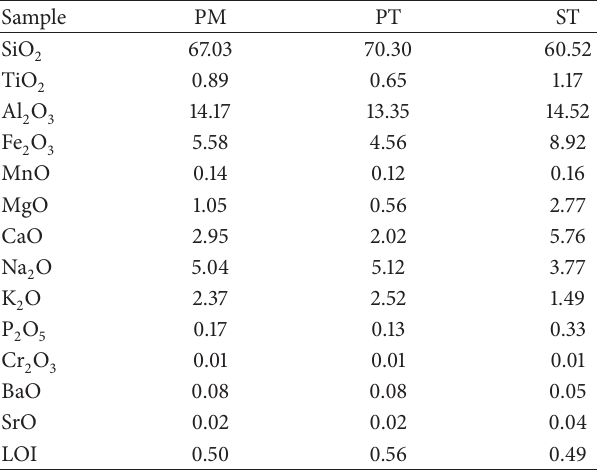
Figure 2: XRD pattern of ST sample (see text). Table 2: Major and minor elements (expressed as % oxides) by ICP AES.